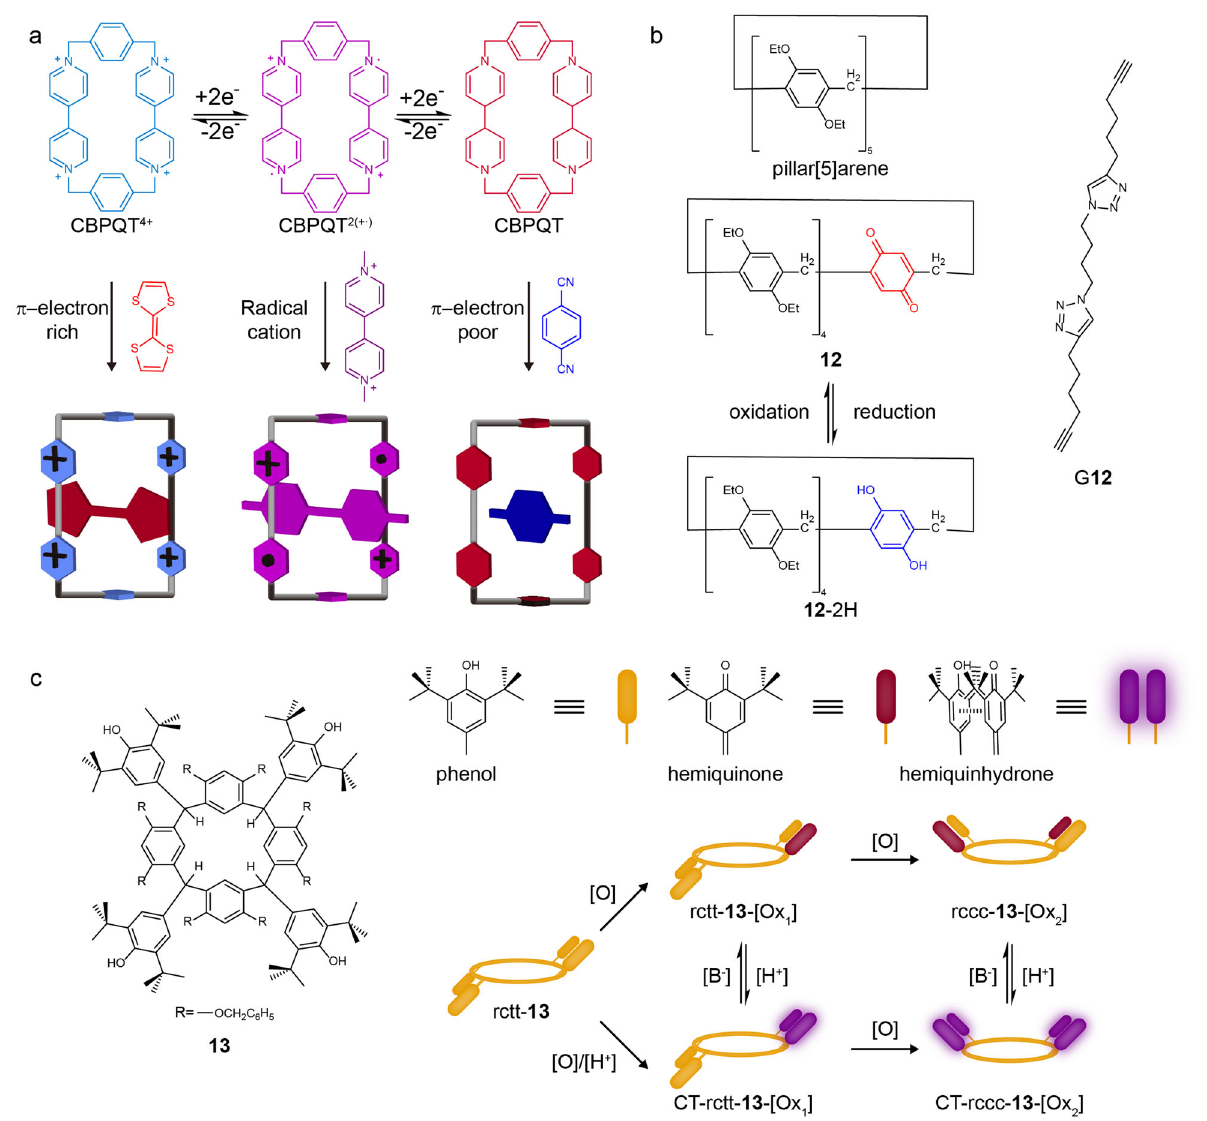
Fig. 3 Redox-responsive macrocycles. a the chemical structures and the speci fi c guest-binding behaves of CBPQT 4 + macrocycle at different redox states 41 . b the structural changes of benzoquinone-contained pillar[5]arene macrocycle 12 during redox stimuli and the structure of testing guest G 12 42 . c the chemical structure of hydroxyphenyl-appended macrocycle 13 and the diversi fi ed chromism of rcct- 13 during stepwise oxidation and acidi fi cation. [O] denotes oxidation; [H + ] and [B − ] denote acid and base, respectively 43